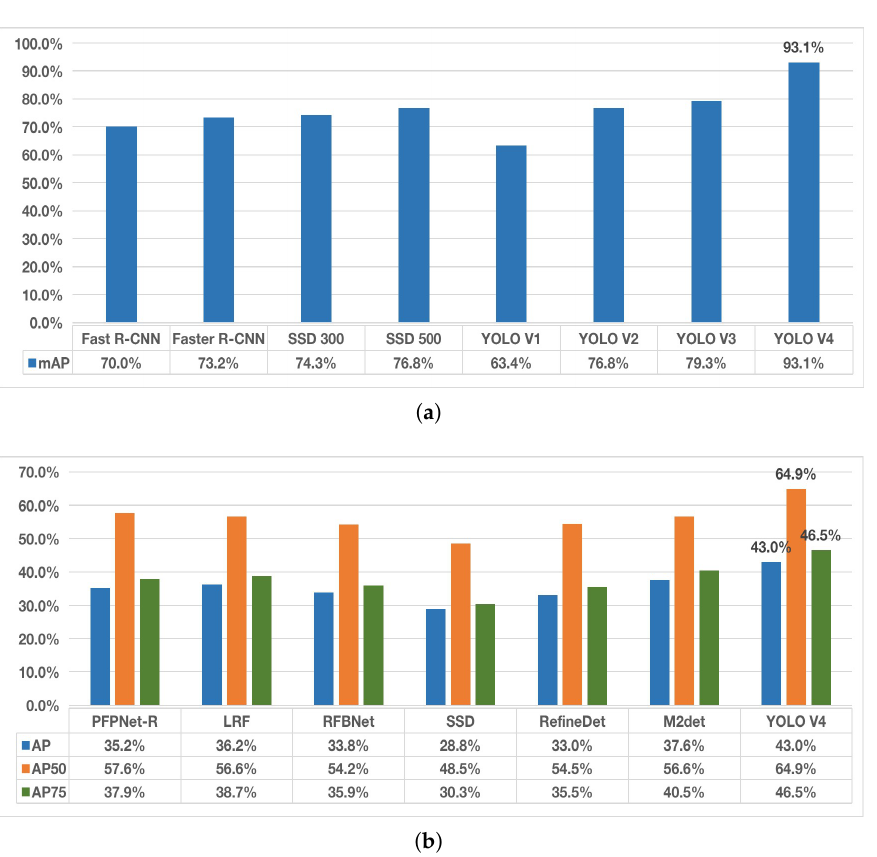
Figure 3. Comparison of YOLO V4 with other mainstream neural networks [20–32]. ( a ) Test results on VOC2007 + VOC2012. ( b ) Test results on the COCO dataset.